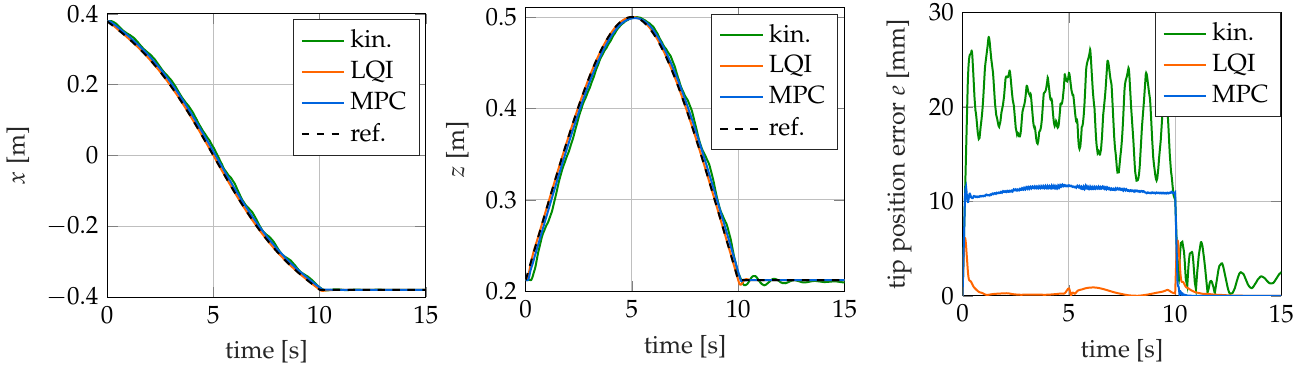
Figure 12. Reference trajectory as well as the tip position for different controllers for the swing trajectory over